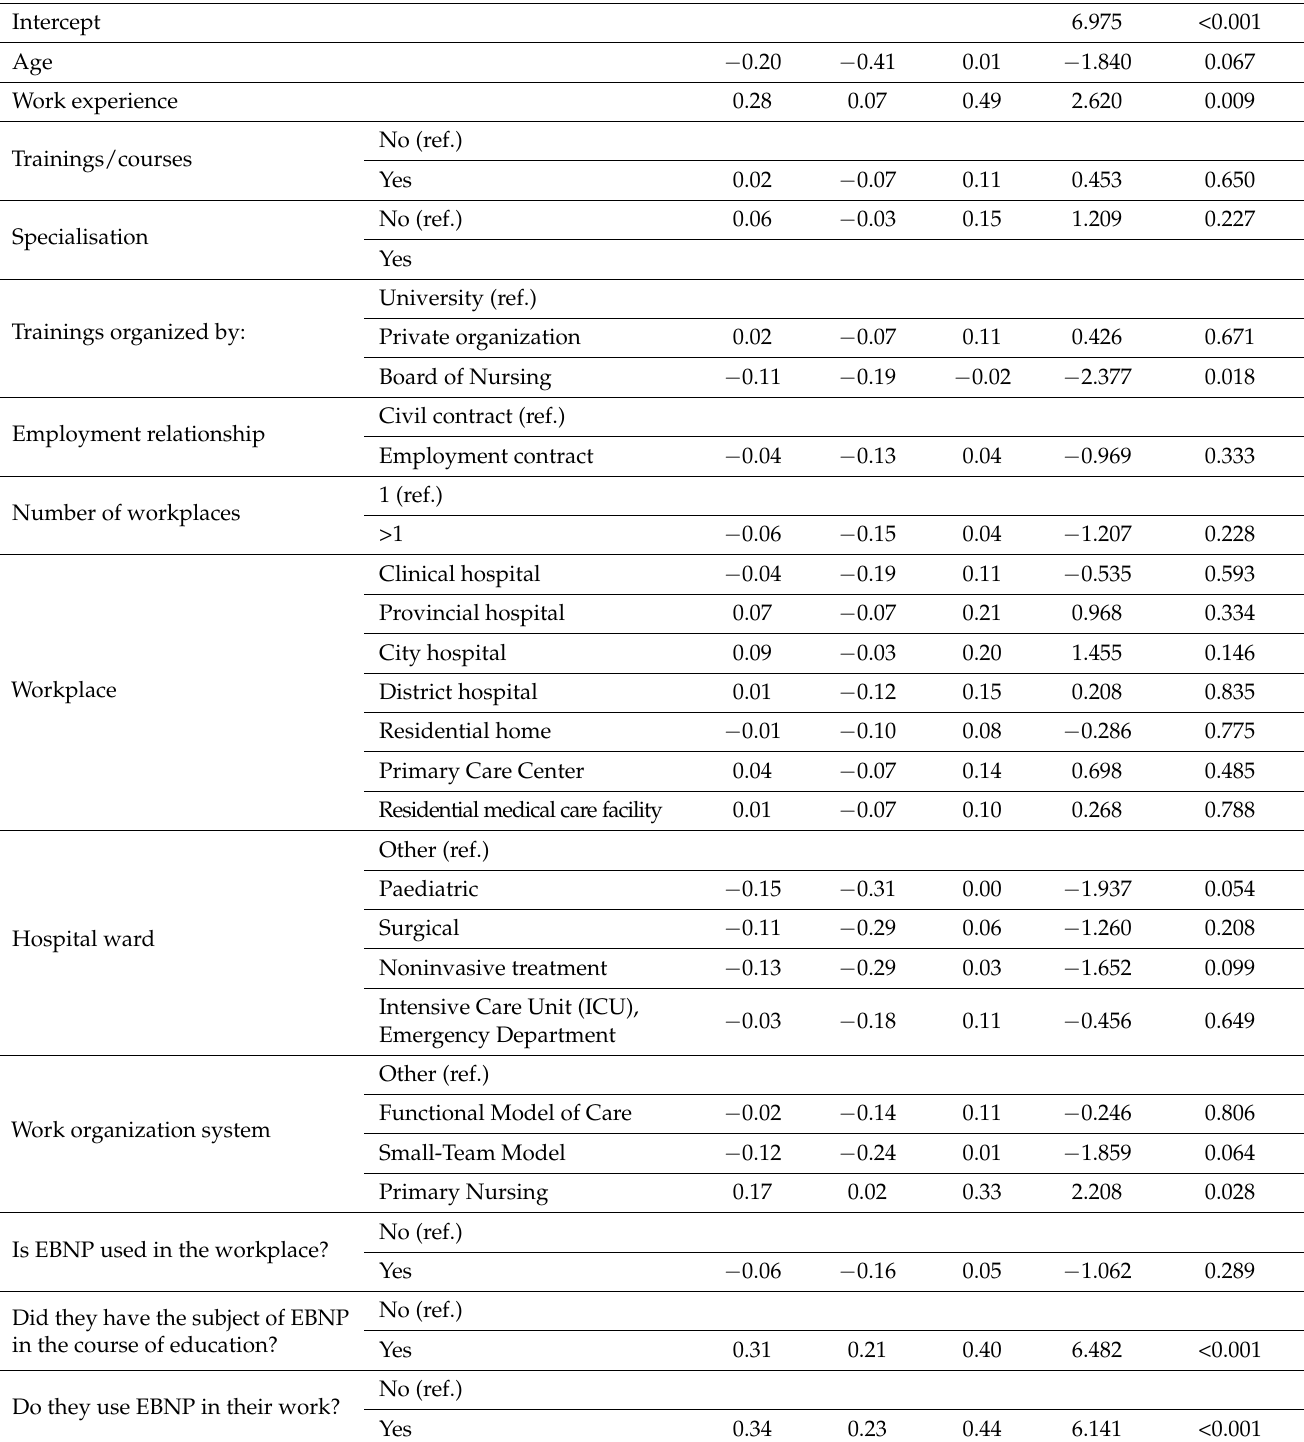
Table 8. Regression analysis for the full multivariate model for the subscale ‘Attitude towards expanding one’s competence in